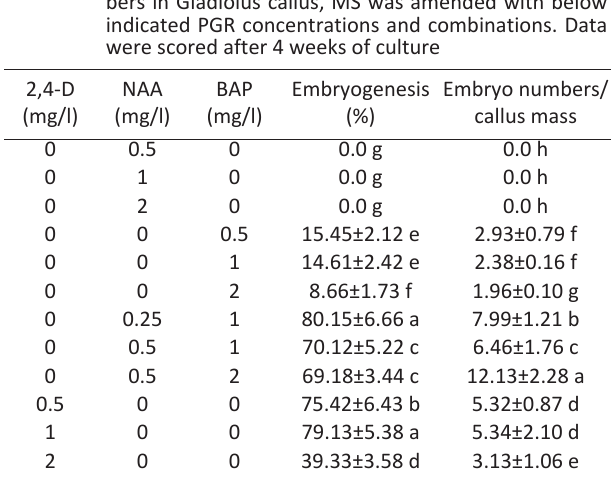
eTable 2 - Embryogenesis percentage and somatic embryo num- bers in Gladiolus callus, MS was amended with below indicated PGR concentrations and combinations. Data were scored after 4 weeks of culture